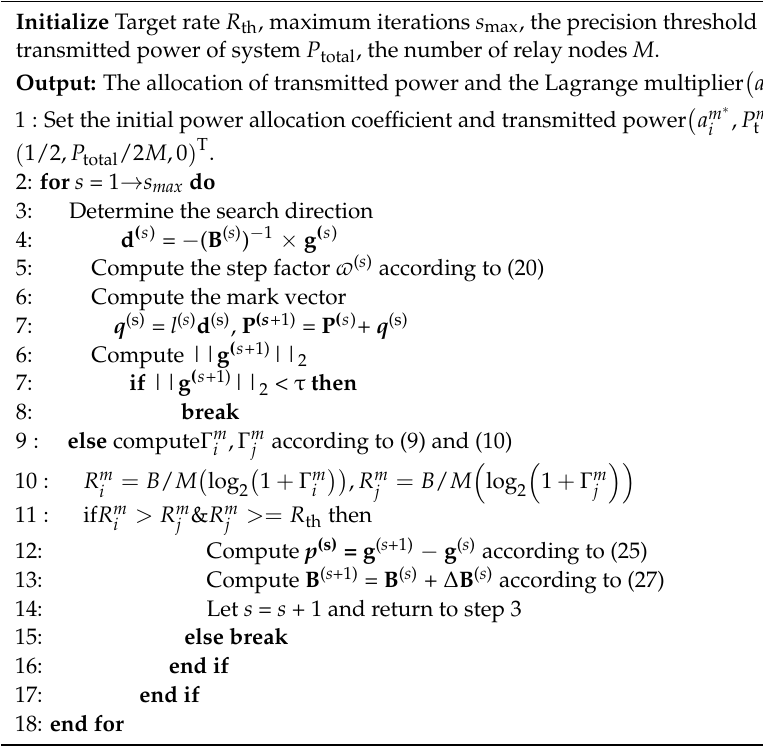
Algorithm 2 Global Optimal Power Allocation